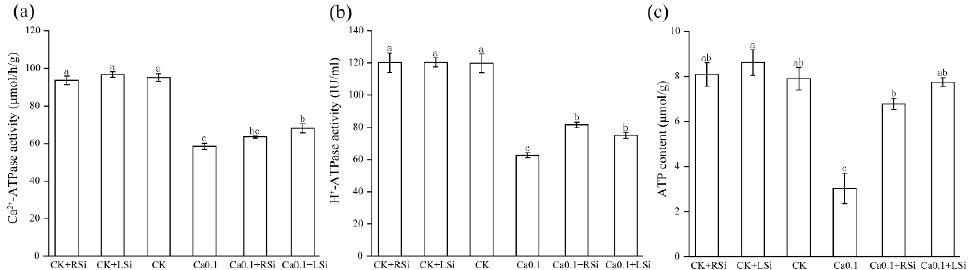
Figure 6. Effect of exogenous Si on chloroplast ATPase activity and ATP content in tomato under low − calcium stress. ( a ) Ca 2+ − ATPase activity; ( b ) H+ − ATPase activity; ( c ) ATP content. The means of three replicates ± standard error is shown. The data were subjected to an ANOVA test to determine the LSD, and bars superscribed by different letters are significantly different at p < 0.05. Standard errors are indicated by bars. CK + RSi: 4 mM Ca in Hoagland nutrient solution + root application of 1 mM Si; CK + LSi: 4 mM Ca in Hoagland nutrient solution + foliar application of 1 mM Si; CK: 4 mM Ca in Hoagland nutrient solution; 0.1Ca: 0.1 mM Ca in Hoagland nutrient solution; 0.1Ca + RSi: 0.1 mM Ca in Hoagland nutrient solution + root application of 1 mM Si; 0.1Ca + LSi: 0.1 mM Ca in Hoagland nutrient solution + foliar application of 1 mM Si.